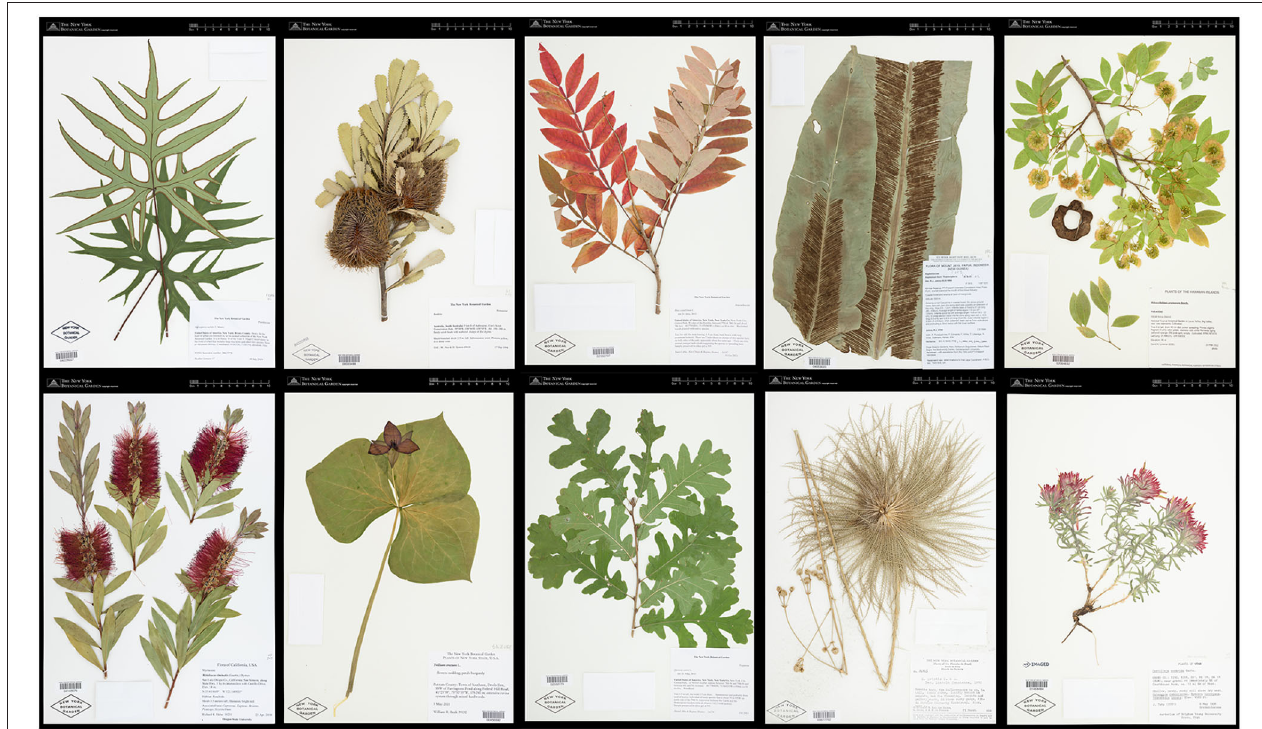
FIGURE 2 | Example of images in the Herbarium 2021 Half–Earth